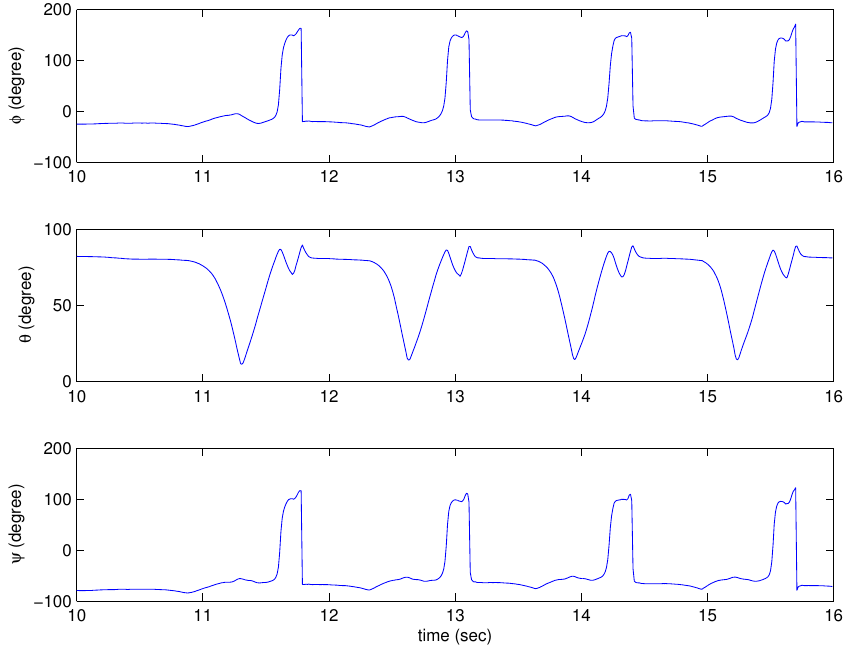
Figure 9. Estimated attitude of the left foot (Euler